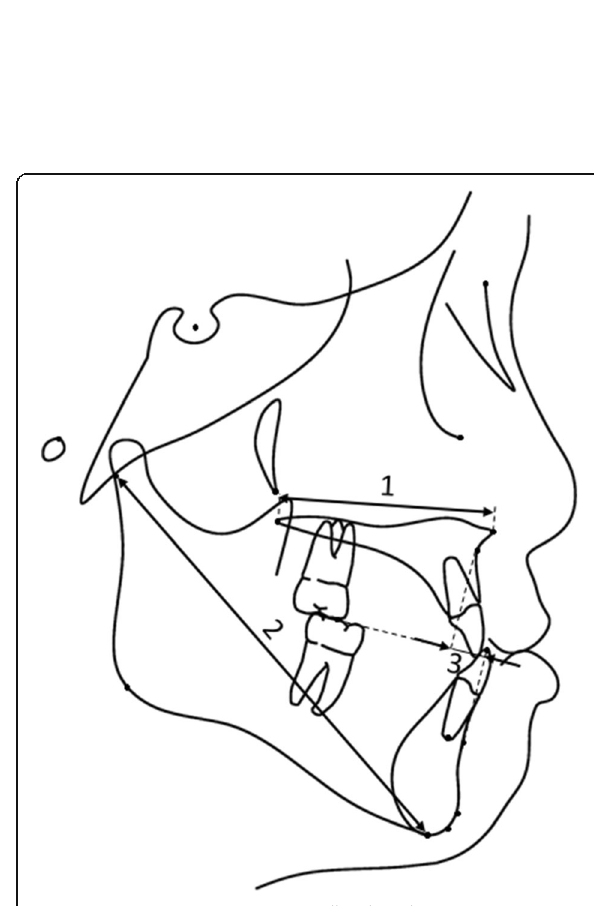
Fig. 2 Linear measurements. (1) Maxillary length (ANS-PNS), (2) mandibular length (Ar-Me), and (3) Wits